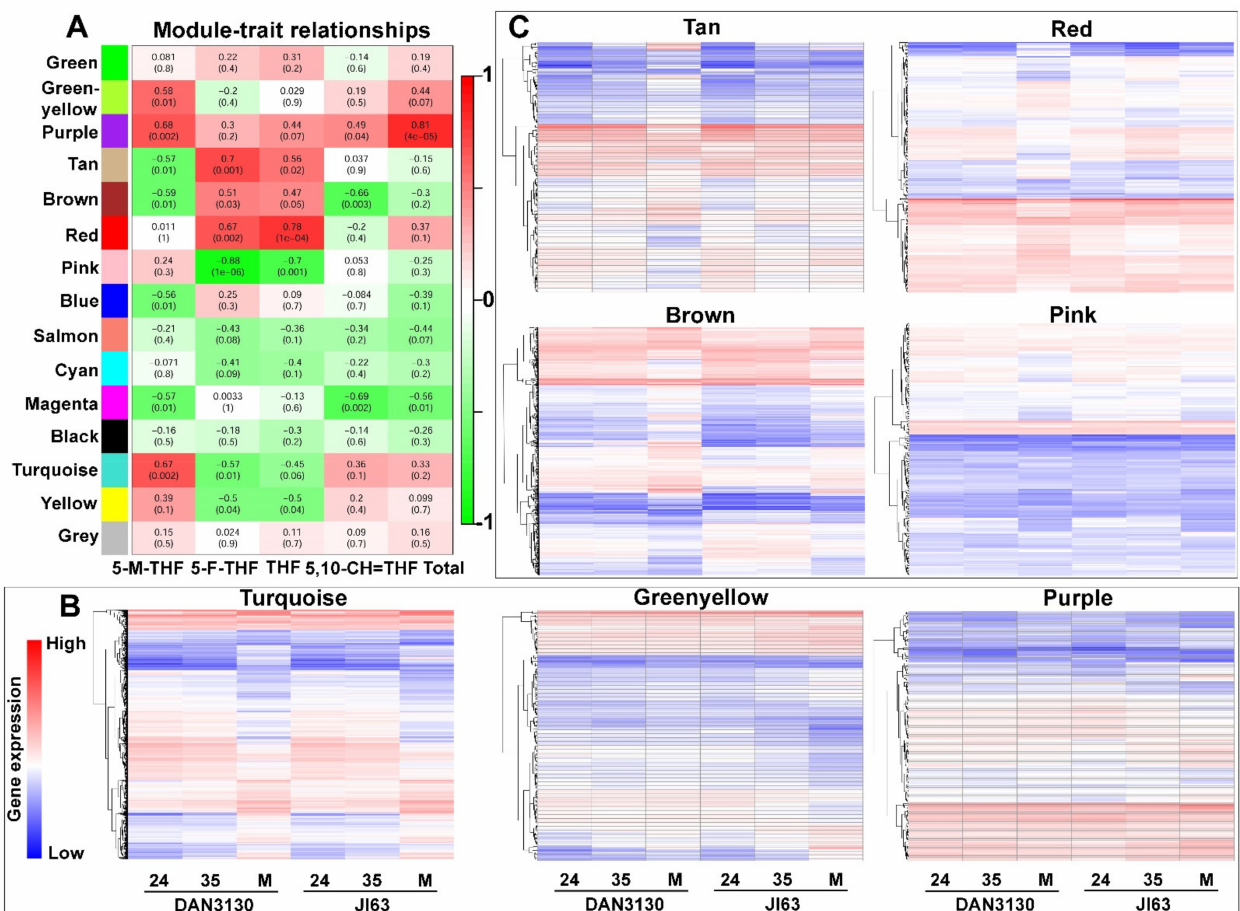
Figure 8. WGCNA analysis of kernel formation. ( A ) Heatmap of the correlation between modules and folate derivatives (each cell contained the correlation coefficient and corresponding p -value). ( B ) Gene expression trends of modules related to 5-M-THF; ( C ) Gene expression trends of modules related to 5-F-THF; 24, DAP 24; 35, DAP 35; M, mature